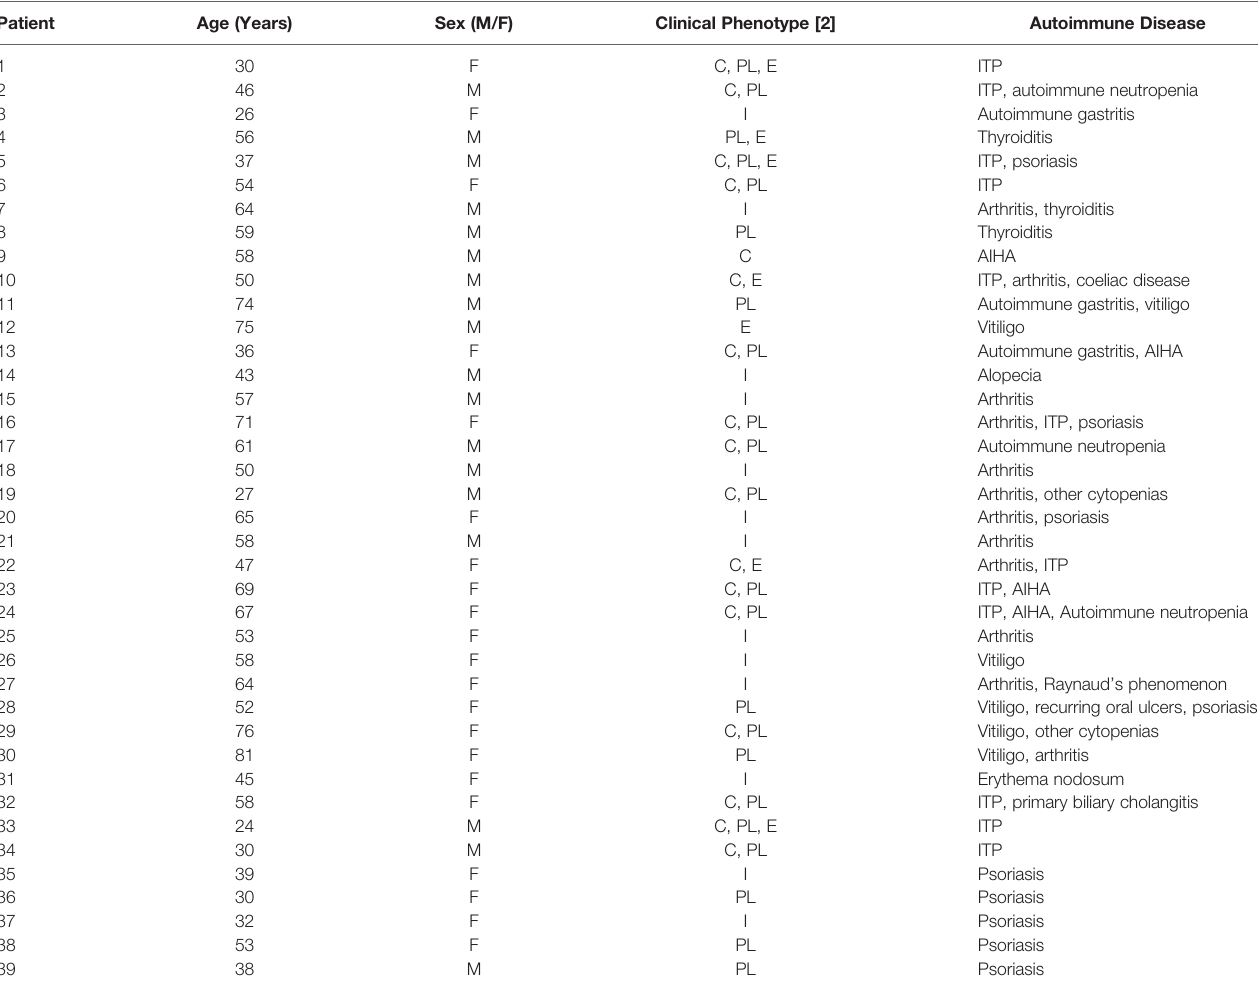
TABLE 3 | Clinical features in our cohort of patients with CVID and autoimmune manifestations.